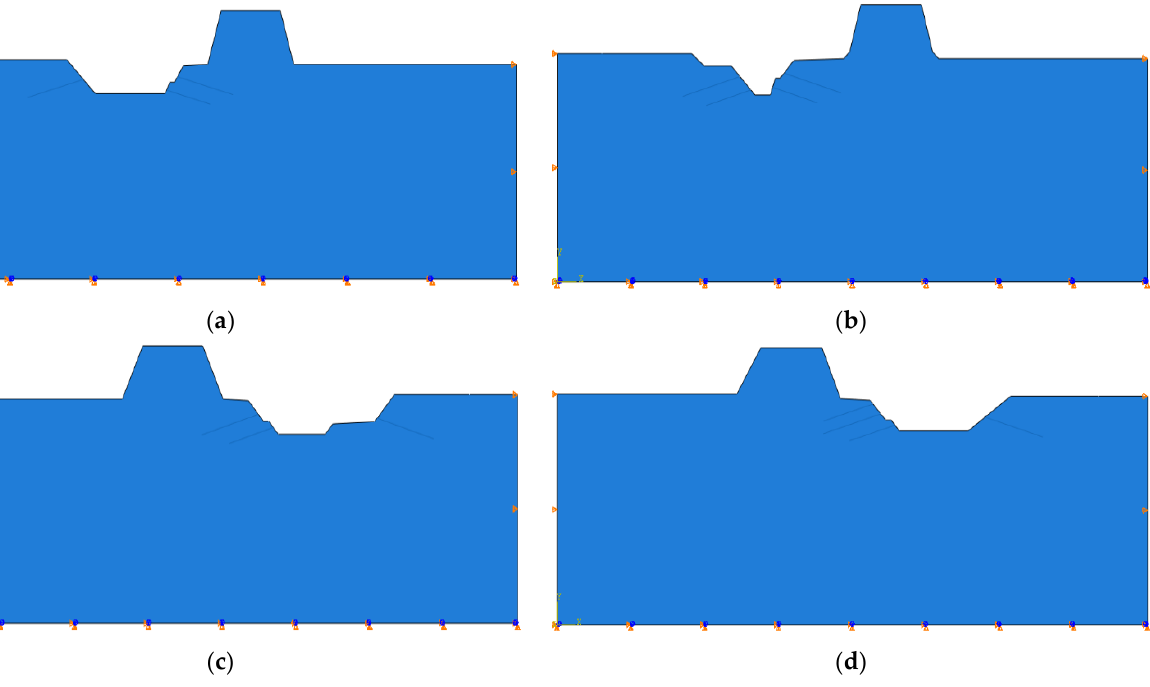
Figure 8. Numerical models of dangerous sections. ( a ) section B–B; ( b ) section E–E; ( c ) section H–H; ( d ) section